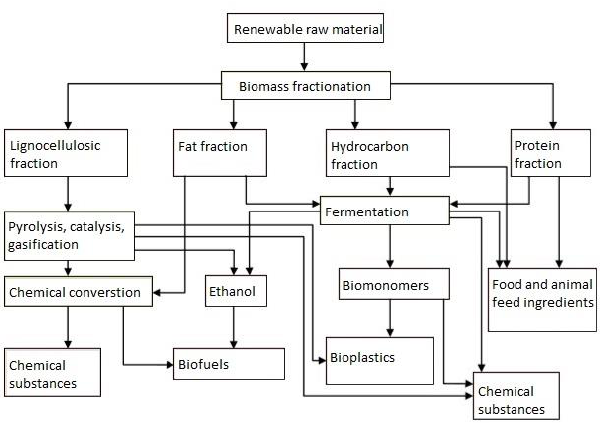
Fig. 1. Biorefinery concept schema [4]